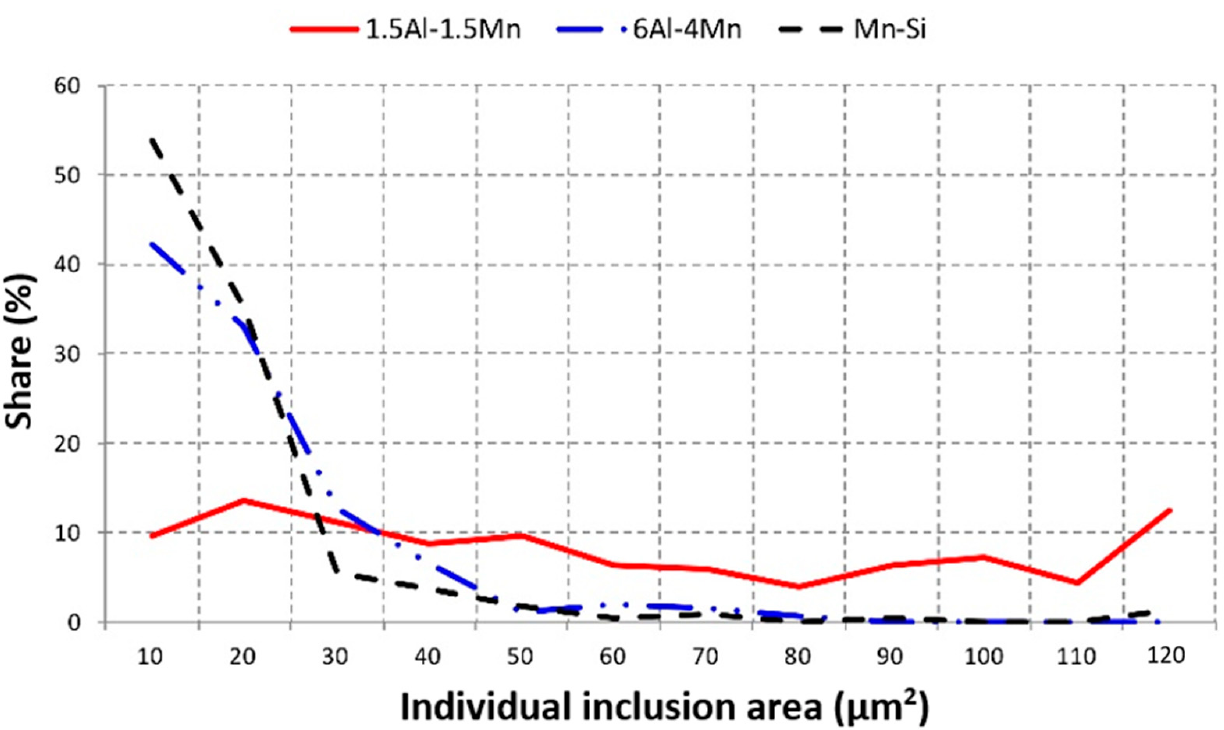
Figure 3. The distribution of the inclusion sizes in the steel samples.